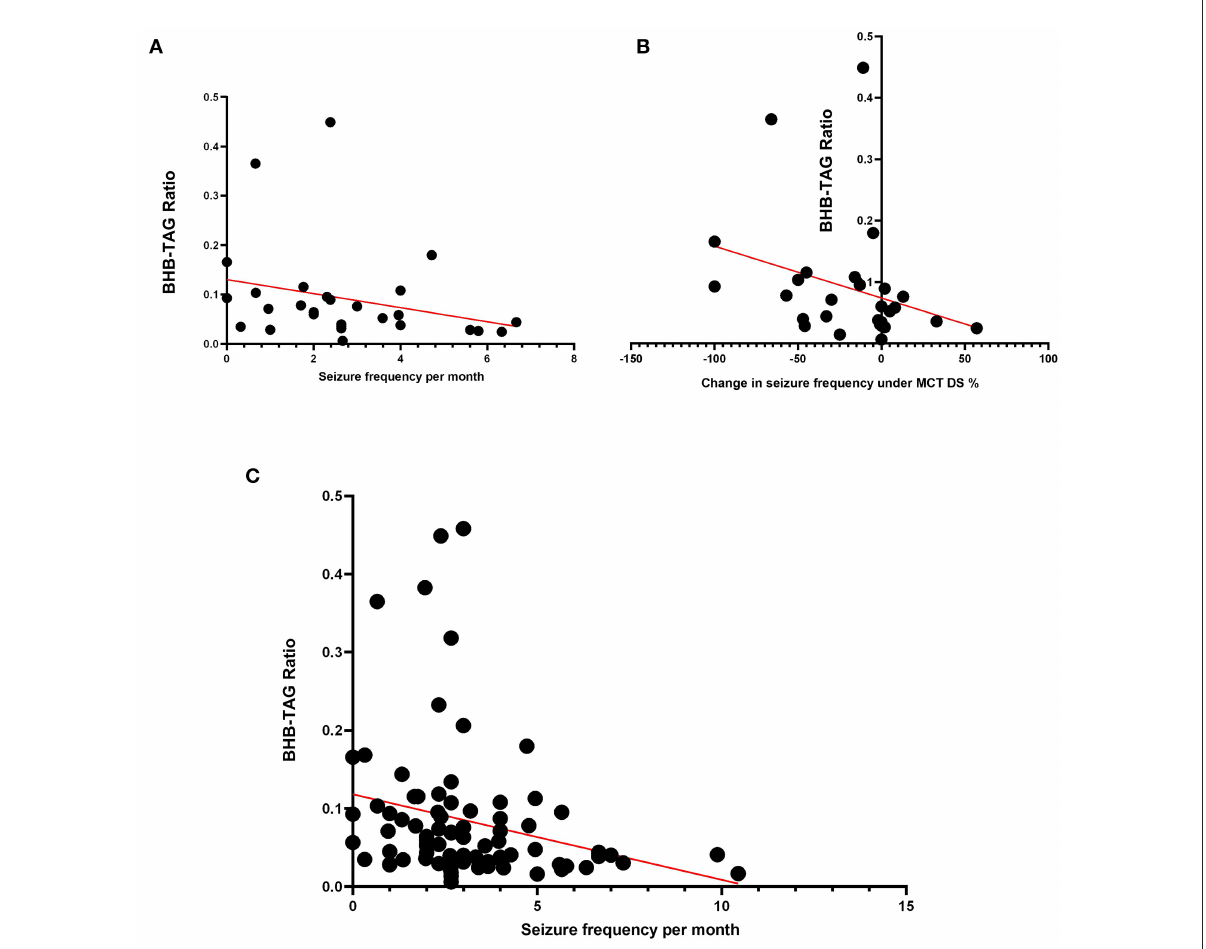
FIGURE4 BHB-TAG Ratio: The BHB-TAG ratio was evaluated on its clinical relevance as a monitoring tool. (A) When MCT was consumed, a significant association between BHB-TAG ratio and seizure frequency per month ( N = 28, p = 0.0150) was found. (B) The relative change in seizure frequency correlated negatively with BHB-TAG ratio ( N = 28, r: − 0.455, p = 0.015) under MCT intake. The lower the BHB-TAG ratio was, the higher the seizure frequency per month, or lower the change in seizure frequency under MCT. The higher the reduction in seizures (–%), the higher the BHB-TAG ratio. (C) Independent of diet or dietary supplementation, a significant negative correlation was found between the occurring seizure frequency per month and the BHB-TAG ratio ( N = 84; r: − 0.387; p =